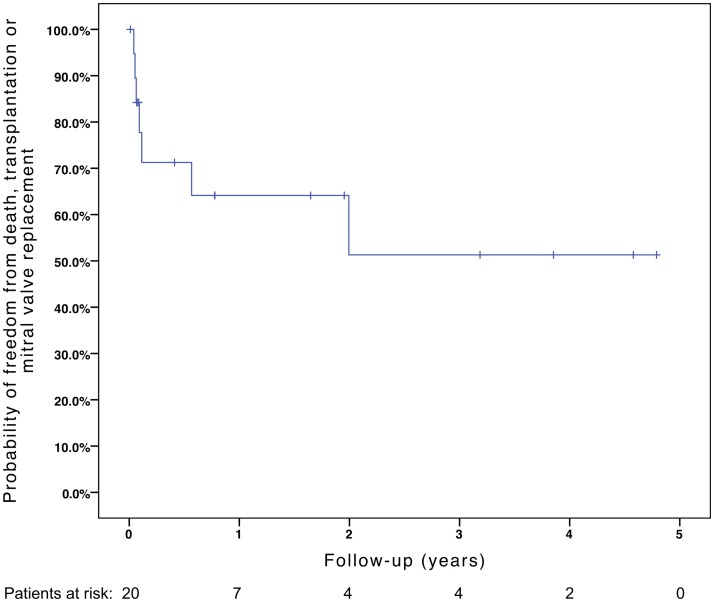
Kaplan–Meier estimate of freedom from death, transplantation, or mitral valve replacement.